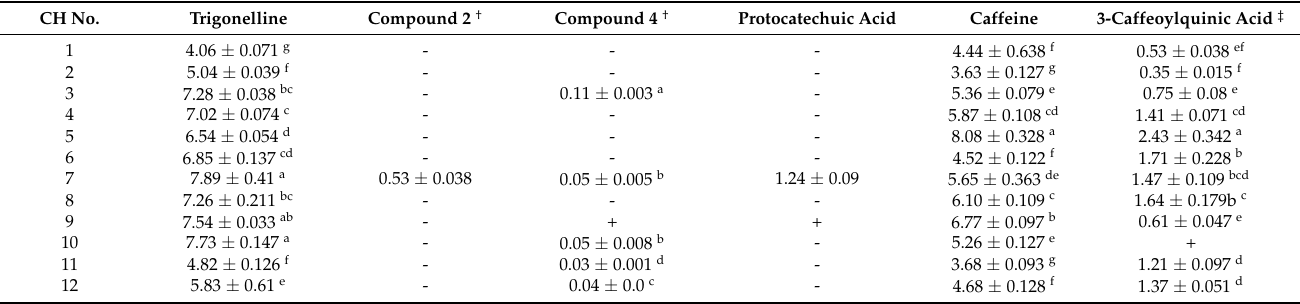
Table 4. Quantification and distribution of the 6 CH compounds